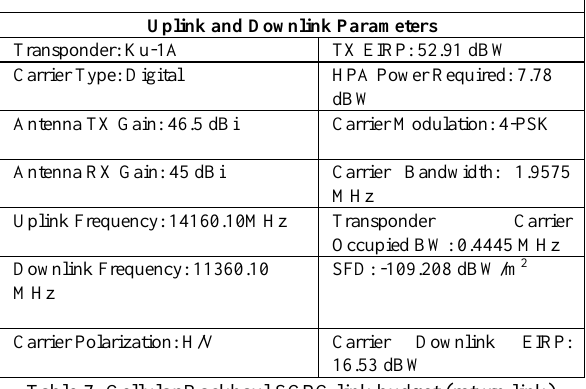
Table 7. Cellular Backhaul SCPC link budget (return